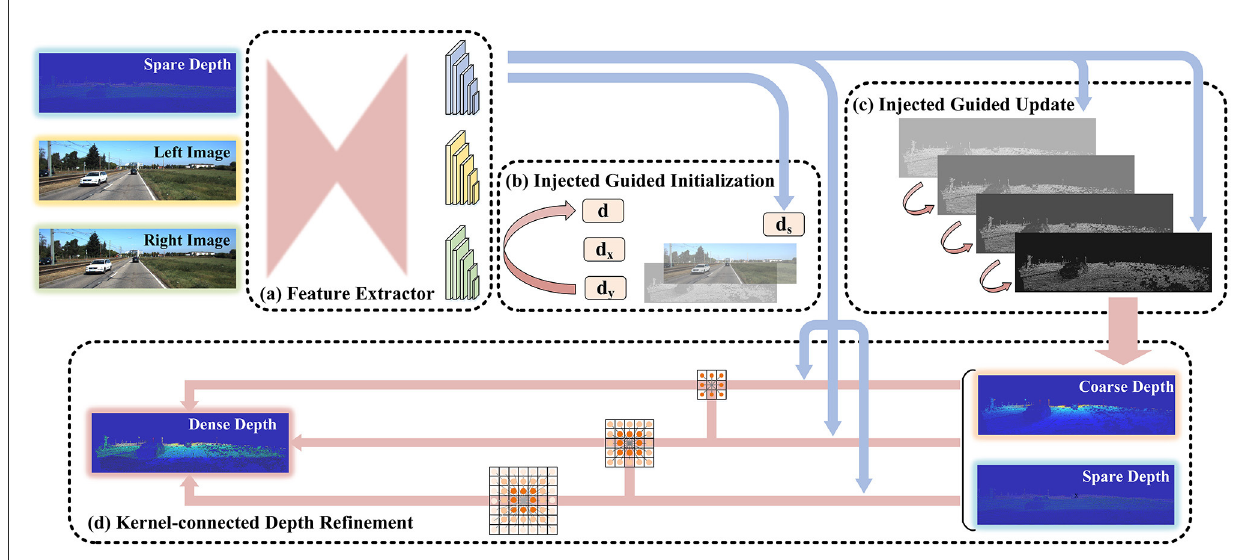
FIGURE1 The structure of our network. The inputs of the network are the sparse depth image from LiDAR and the image pair from the binocular camera. The output is the dense depth image. Initially, the multi-source images get the corresponding features through the feature extractor with shared weight. Then, the coarse depth is obtained by initializing and iteratively updating the depth information under the guidance of the features of the point cloud. Finally, the depth is optimized in the refinement module to obtain the dense depth image.